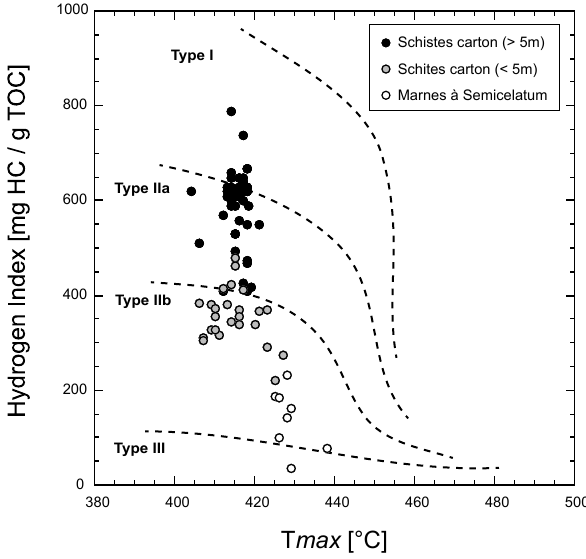
Figure 5. Pseudo van Krevelen diagram showing the origin of the organic matter of the Lower Toarcian samples of the Bascharage section. The typology of the organic matter according to combined hydrogen index and T max values is after Tissot et al. (1971). Sym- bols correspond to the (litho)stratigraphic position of the samples across the section. Key is inset upper right. The samples show a progressive increase in HIs throughout the section, indicating a pro- gressive change from continental (Type III)- to marine (Type II)- dominated organic matter. Representation of T max /HI, as referred to as a pseudo van Krevelen plot is from Espitalié et al. (1986).